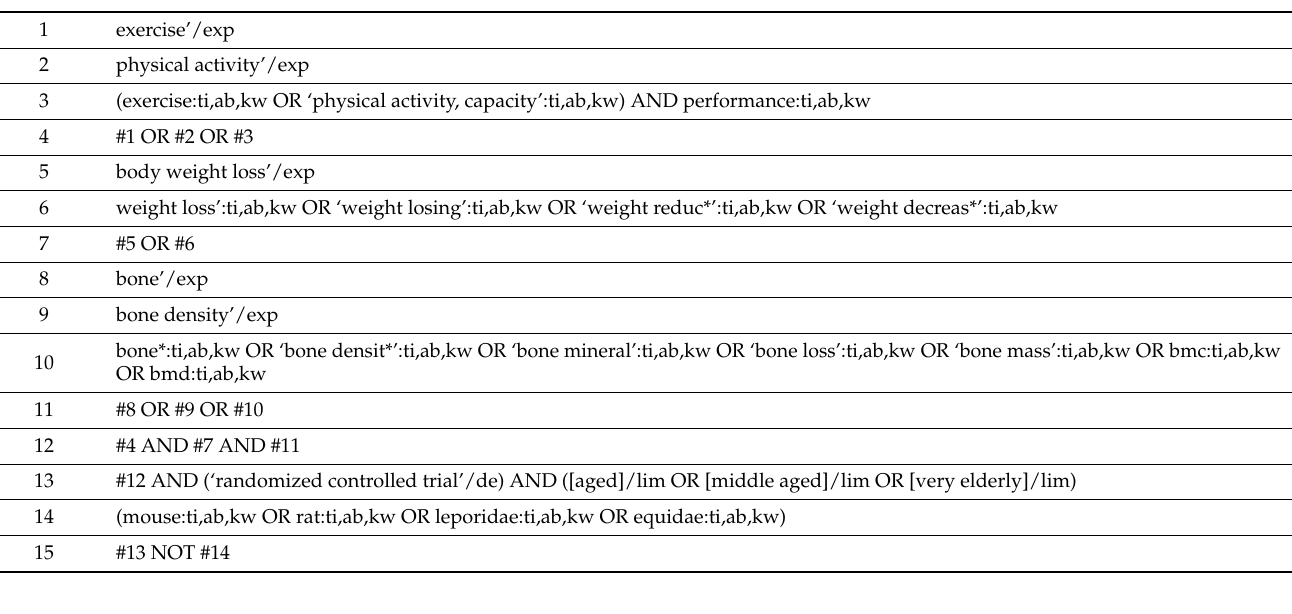
Table A1. Embase search strategy.